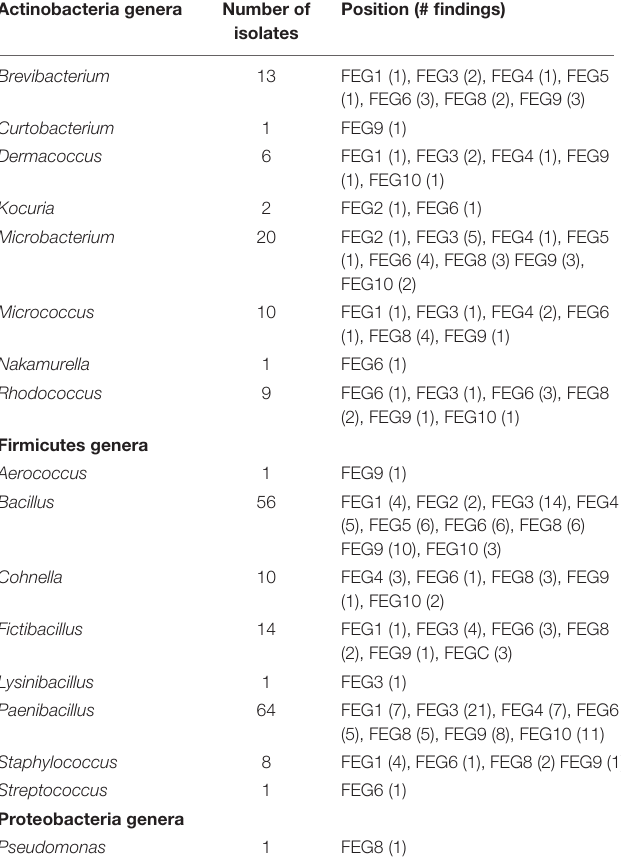
TABLE 4 | Bacterial genera isolated from the FEG